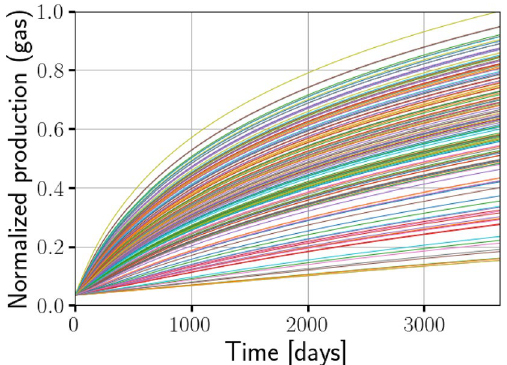
Figure 6. The normalized cumulative production obtained from 150 high-fidelity simulations for a time-span of 10 years is shown. The production curves show an appreciable spread corresponding to the variance in the data. The simulations correspond to 150 samples of various parameters determined by the model of the fracture network. The fracture network model is based on data from the MSEEL site.